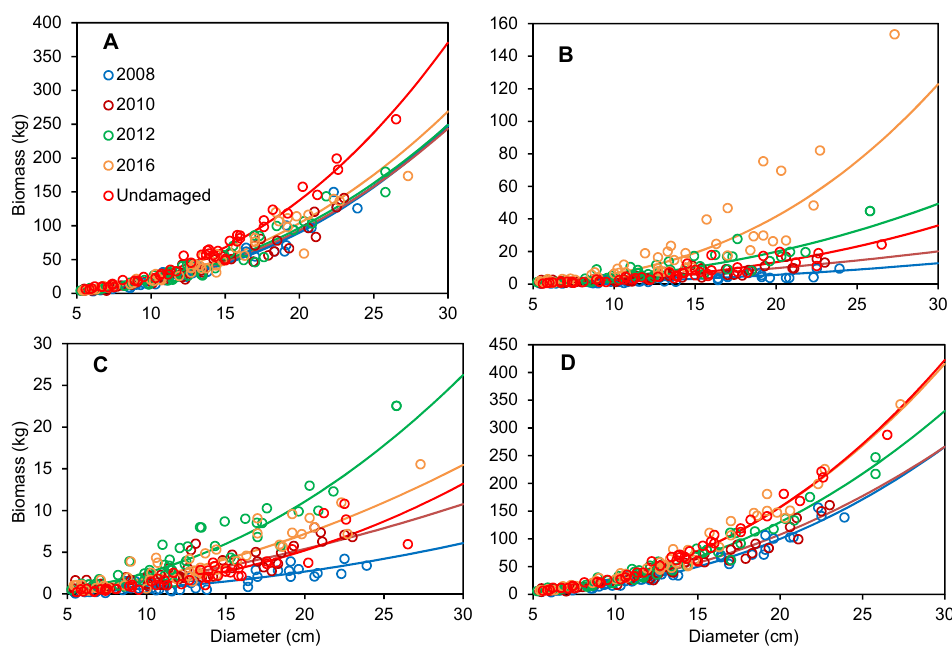
Figure 2. The relationships between diameter and biomass of different compartments of trees at different recovery stages after the ice storm disaster. ( A ) trunk, ( B ) branch, ( C ) leaf and ( D ) aboveground. The solid lines with different colors are regression equations.